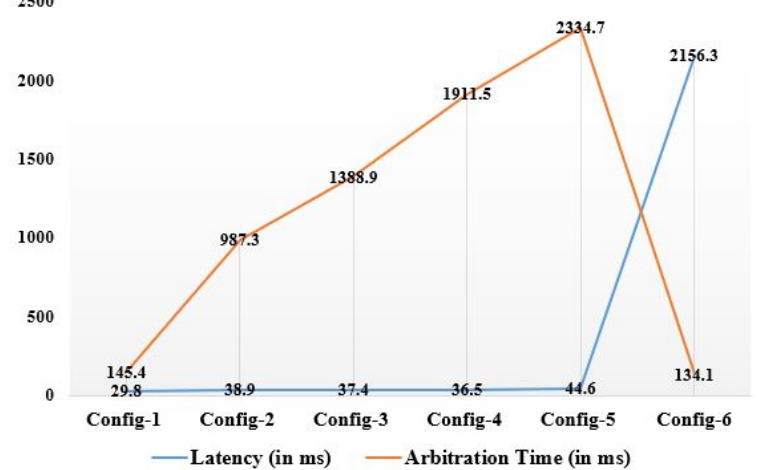
Figure 8. Latency vs. arbitration time over various configurations.